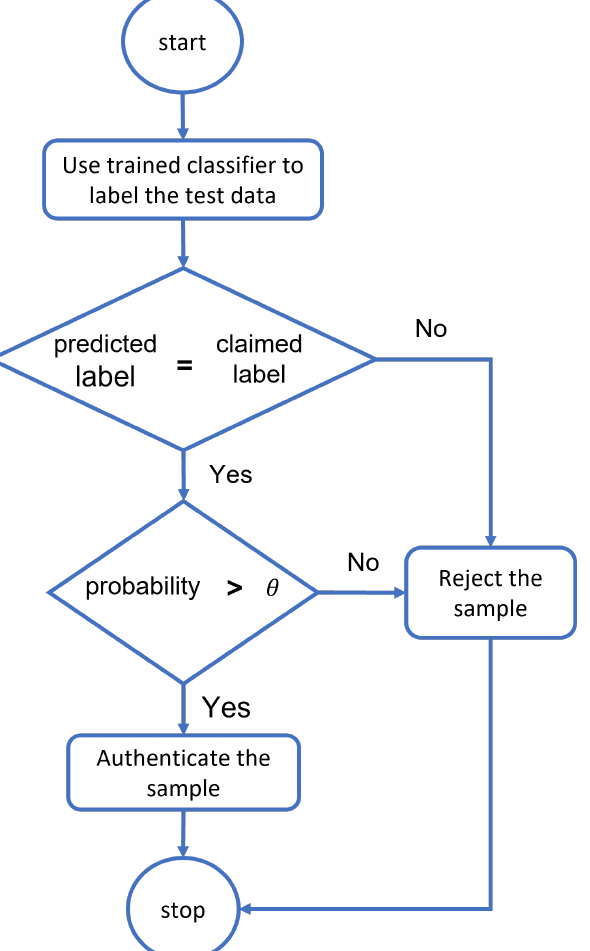
Figure 7. The flowchart of threshold-based classifiers for